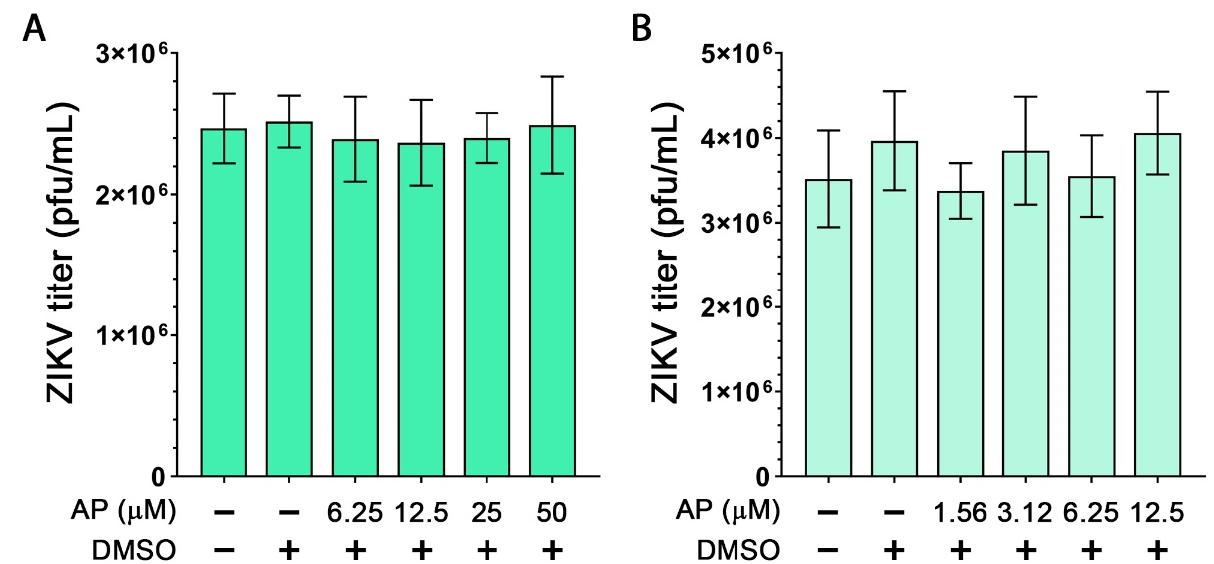
Figure 3. Effects of AP on ZIKV. ( A ) Virucidal activity of AP was determined by incubating ZIKV with complete media, DMSO, or various concentrations of AP at 37 °C for 2 h followed by plaque assay. ( B ) TPA-induced THP-1 cells were infected with ZIKV (MOI of 5) for 2 h. After infection, complete media, DMSO, or various concentrations of AP were added and incubated for 48 h. Sample supernatants were harvested to examine ZIKV viral productivity by plaque assay. Each condition was performed three times with duplicate plaque assay.